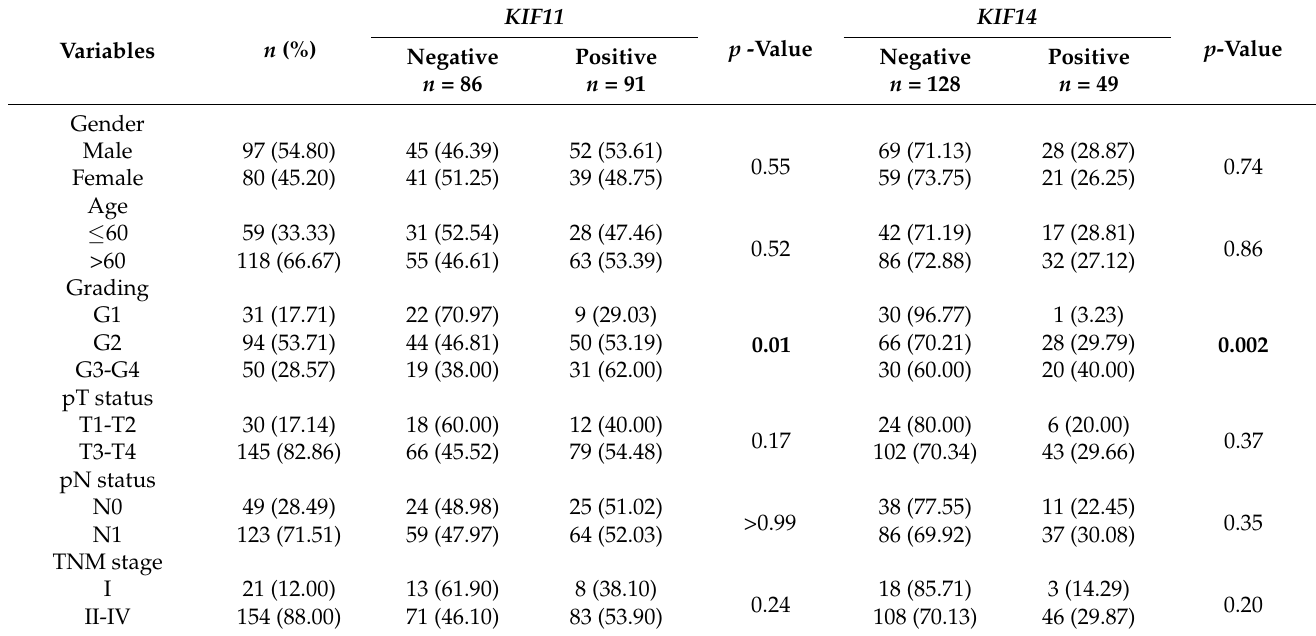
Table 5. Characteristics of the TCGA cohort by KIF11 and KIF14 expression